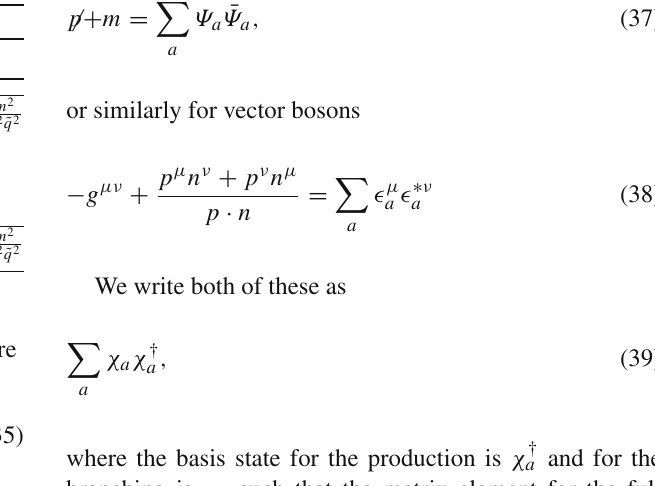
Table 3 Spin unaveraged splitting functions for q → qg . In addition to the factors given above each term has a phase e i φ (cid:3) (λ 0 − λ 1 − λ 2 ) , where λ = ± 1 for the outgoing gluon and λ 2 Herwig ++ evolution